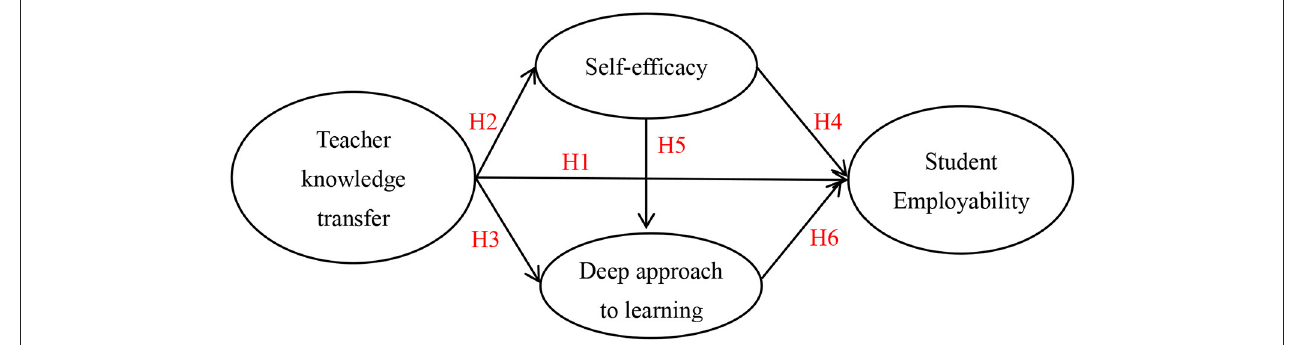
FIGURE 1 | Research framework.